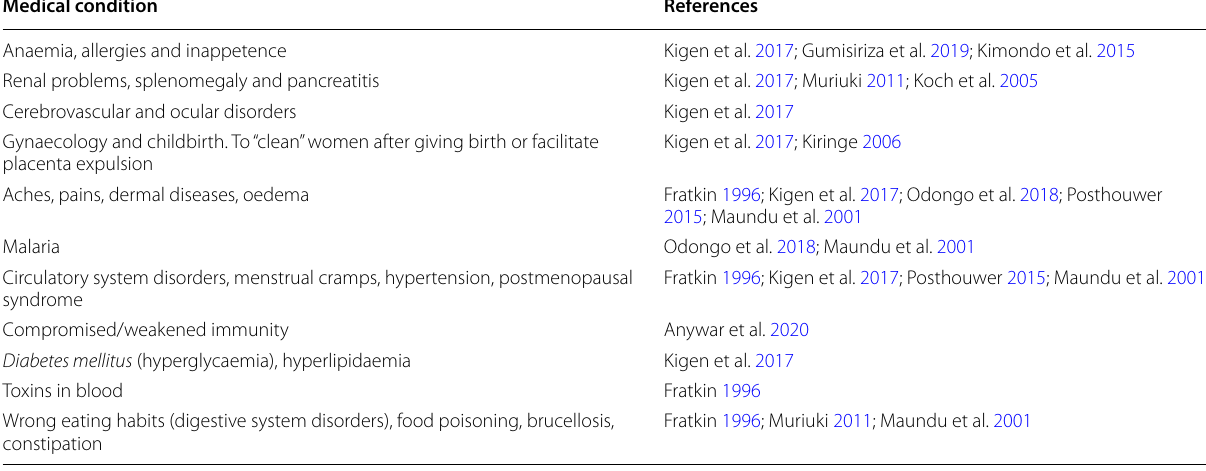
Table 1 Conditions linked with the need for a blood purifier, cleanser, detoxifier or tonic according to East African folk medicine